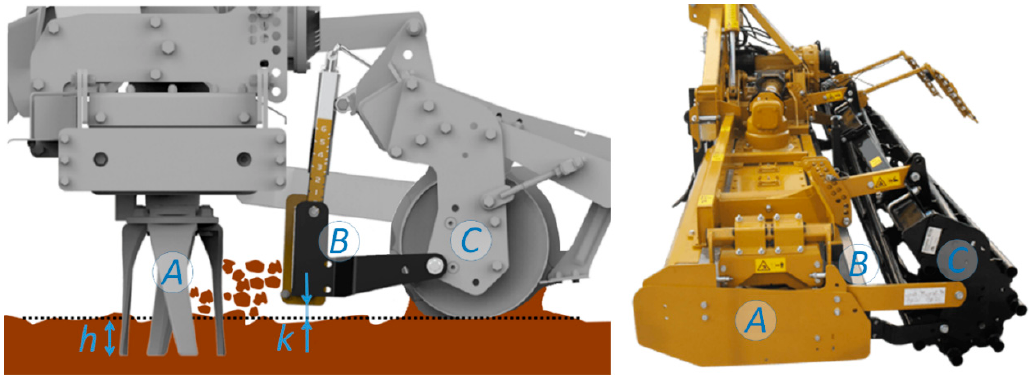
Figure 1. On the left schematic view and on the right a picture of the implemented harrowing machine, with indication of the working depth h of the rotary tines ( A ) and of the height k of the levelling bar ( B ) closing the back part of the working volume; Soil is eventually levelled by a couple of cage rollers ( C ).